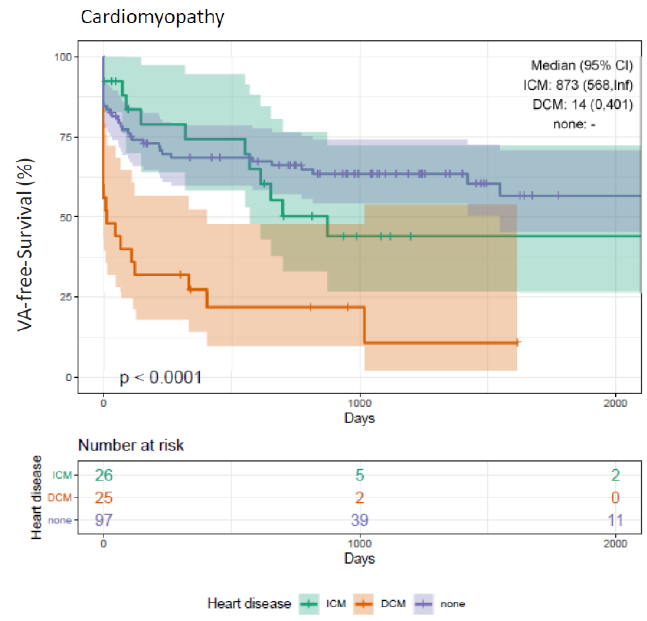
Figure 3. Kaplan–Meier plot on freedom from VA recurrence in patients undergoing RMN ablation with cardiomyopathy (DCM, ICM) compared to patients without. Patients undergoing RMN ablation for VA with DCM present with a significantly worse outcome compared to patients with ICM and patients without cardiomyopathies (DCM, ICM) (log-rank p -value < 0.001*). VA, ventricular arrhythmia; VT, ventricular tachycardia; PVC, premature ventricular contractions; RMN, remote magnetic navigation; ICM, ischemic cardiomyopathy; DCM, dilated cardiomyopathy; None, absence of cardiomyopathy (DCM, ICM); FU, follow-up. Uni- and multivariate Cox regression analyses found DCM to be an IP for VA recurrence associated with a 3.7-fold increase in recurrent VA. ICM patients presented with a 56% increase in VA recurrence (Tables 2 and 3). Table 2. Univariate Cox regression analysis of risk factors for VA recurrence of patients undergoing RMN ablation.